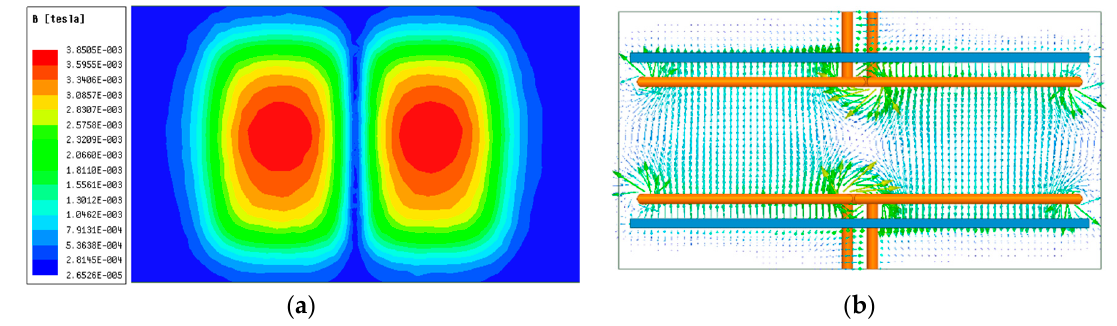
Figure 15. Magnitude plot ( a ) and vector plot ( b ) of the B field between Tx and Rx of the DD–DD configuration.